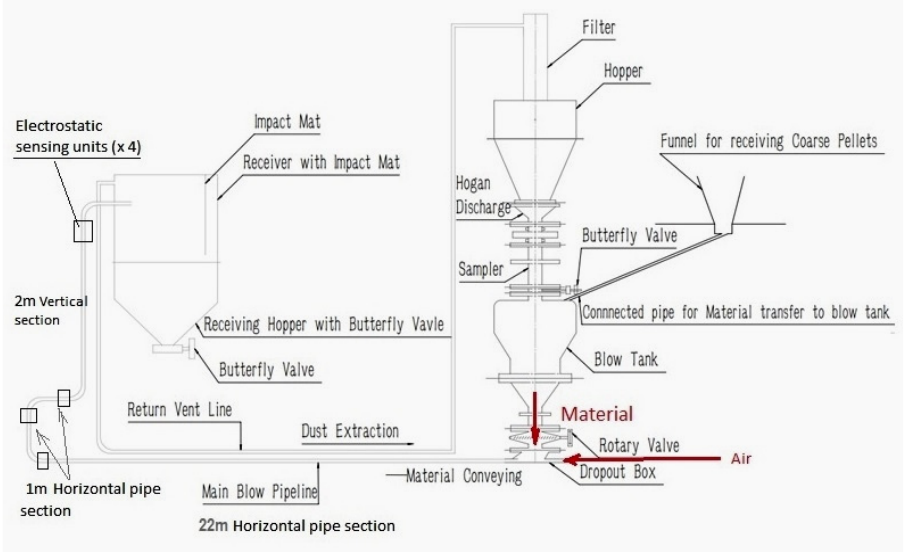
Figure 2. Full-scale industrial pneumatic conveying the test rig at The Wolfson Centre with a Line diagram showing bends in proximity at the end of the pipe with the full-scale test rig (pipe dimensions in the line diagram are not scaled).